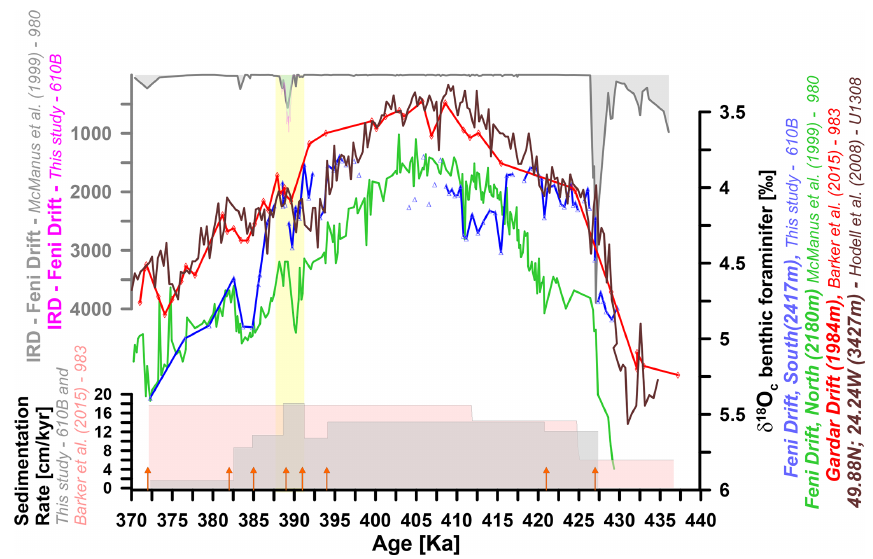
Figure 4. Age model development for DSDP 610B (370–470ka): IRD records from DSDP 610B (pink) and ODP 980 (grey) from the Feni Drift; δ 18 O benthic foraminifera records from DSDP 610B (blue), ODP980 (green, and ODP 983 (red), IODP 303-U1308 (brown) corrected by 0.63‰; and the sediment rate (in cmkyr − 1 ) for DSDP 610B (grey) and ODP 983 (light-pink). The yellow band marks the MIS11b event. Arrows indicate tie